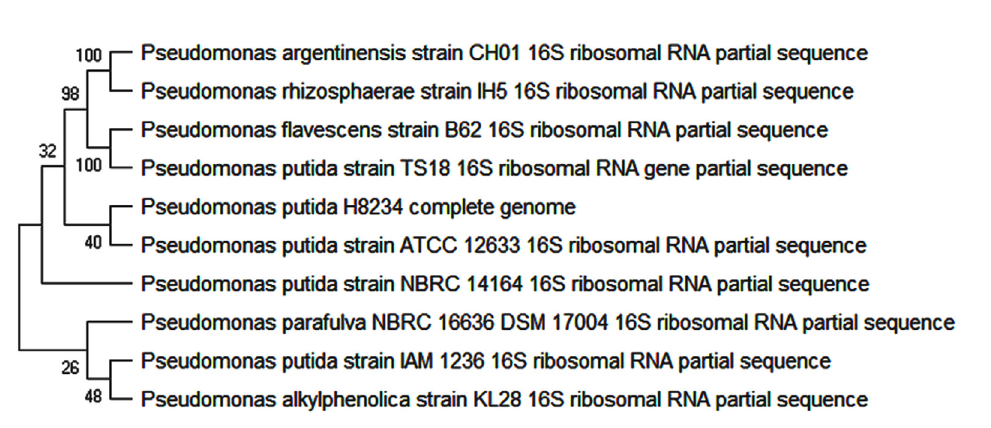
Fig. 2. Phylogenetic tree of Pseudomonas putida TS